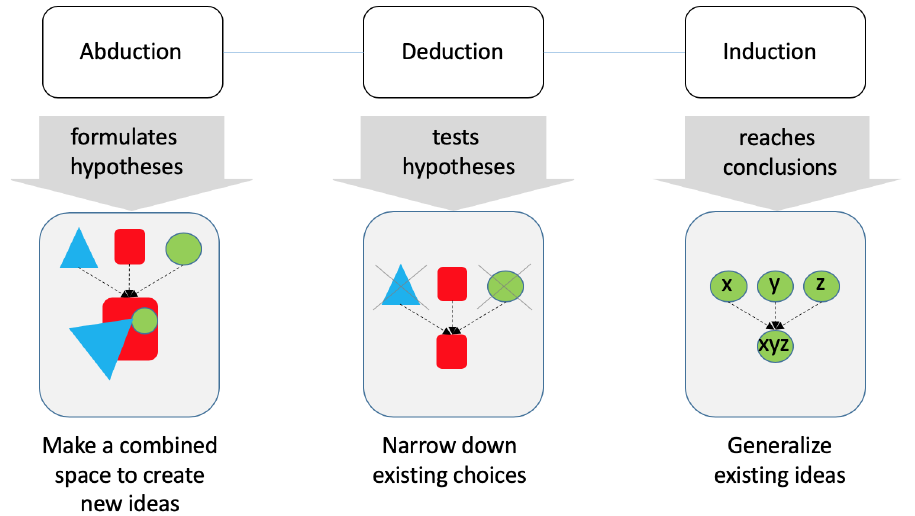
Figure 2. The process steps of the reasoning